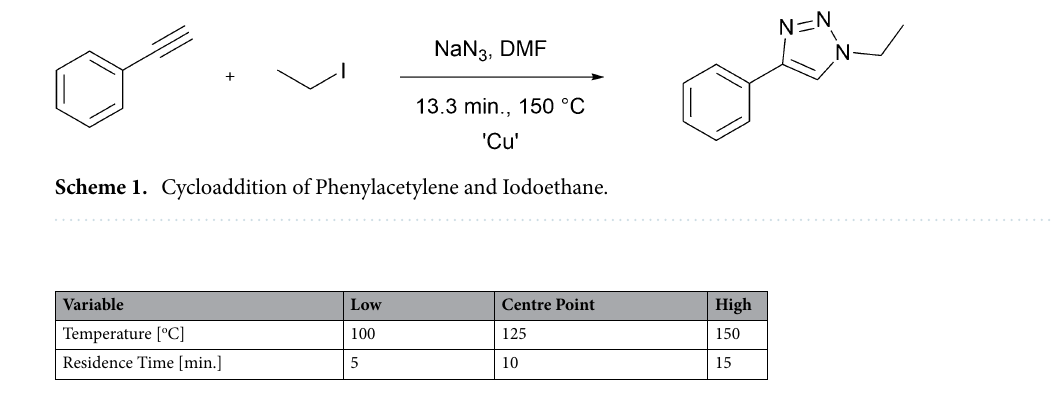
Table 2. Design of Experiments (DOE) parameters used in reaction optimisation.